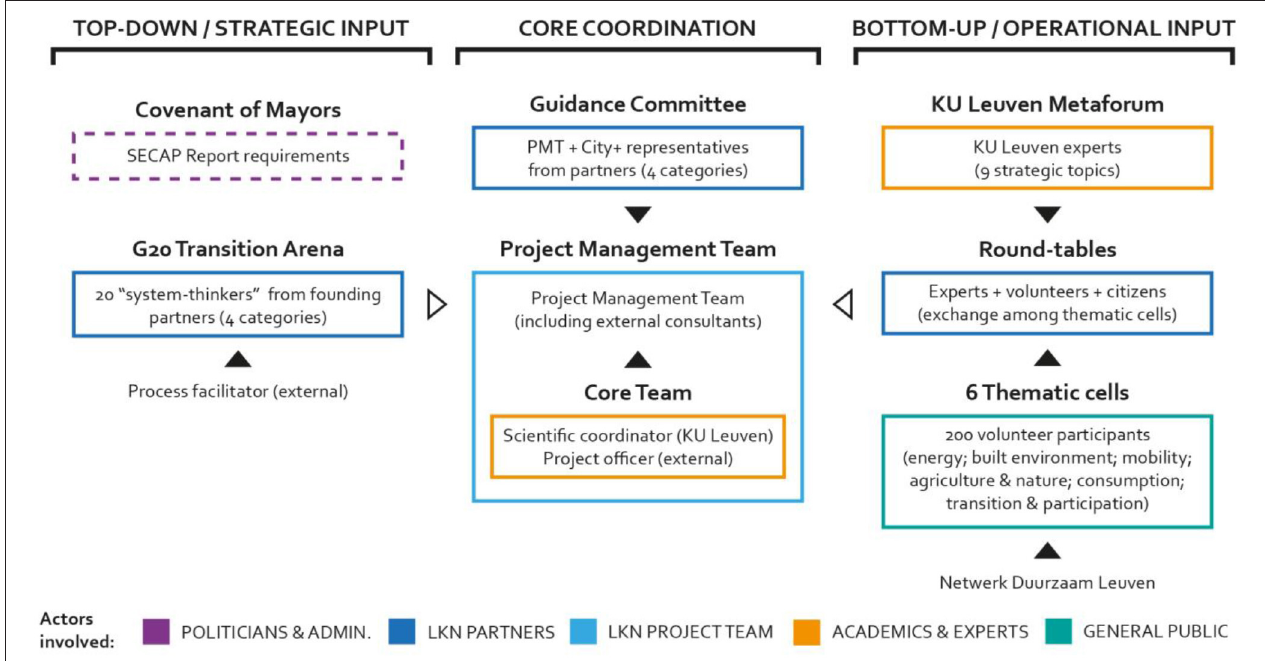
FIGURE 4 | Coordination of the development of LKN’s report. (Source: author’s adaptation from Vandevyvere et al., 2013).